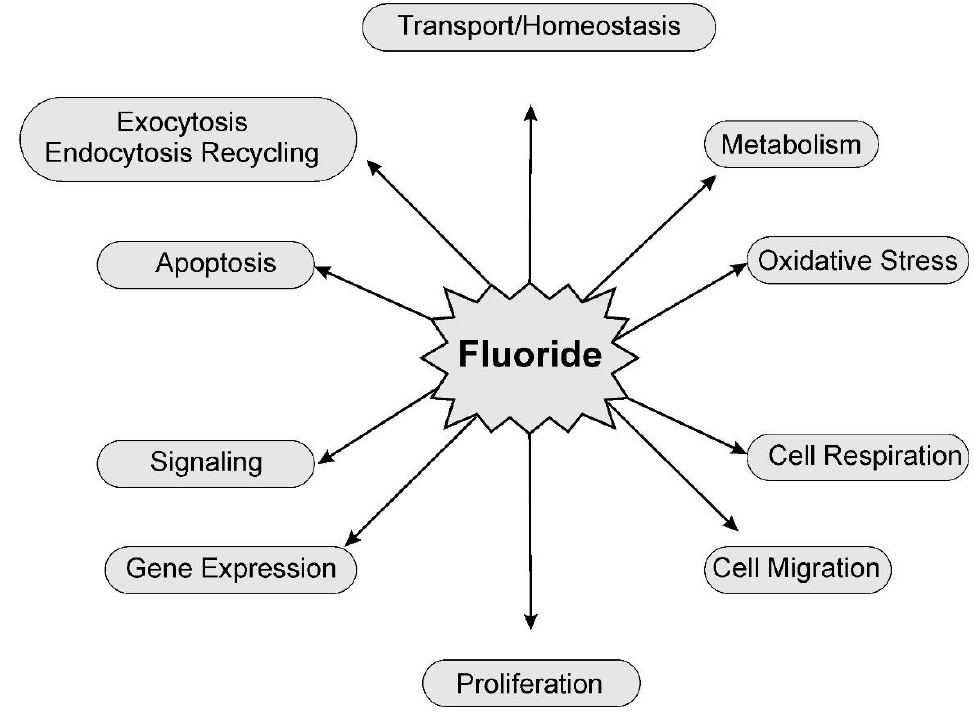
Figure 2: General scheme of the biological consequences of fluoride exposure on mammalian cells (modified after Barbier et al .,